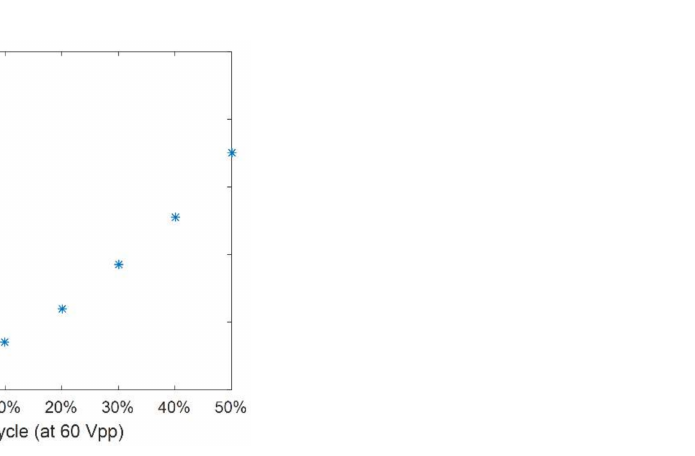
Figure 10. The temperature rise of thrombus interior at each duty cycle (at 1.1 MHz, 60 V pp input voltage, 500 PRF).